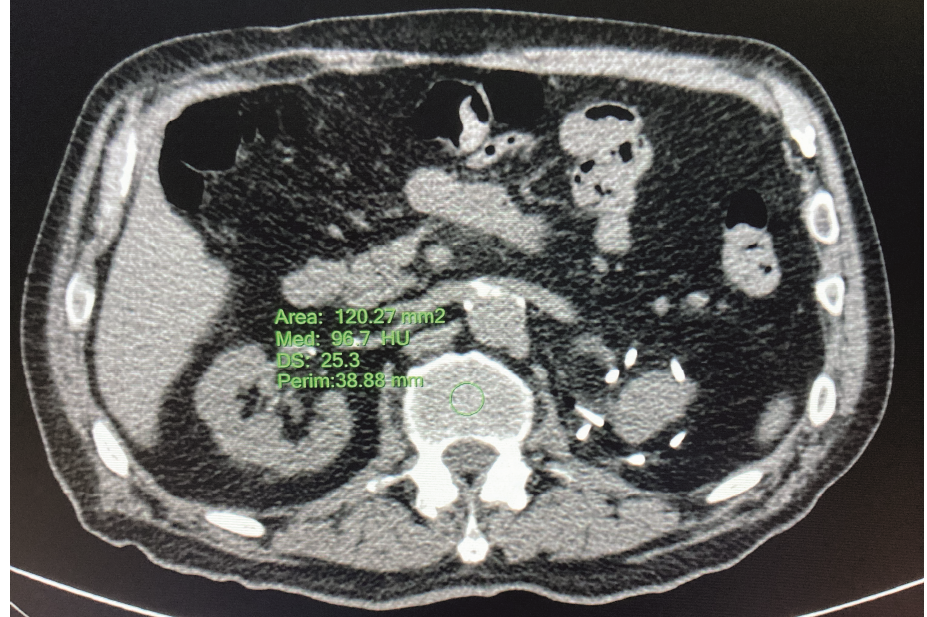
Figure 3. L1 bone mineral density. Credits: AUSL Romagna.